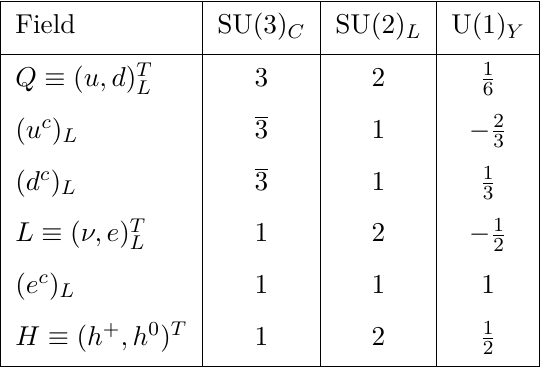
Table 2 . Notation for the representations of the SM fermion and Higgs